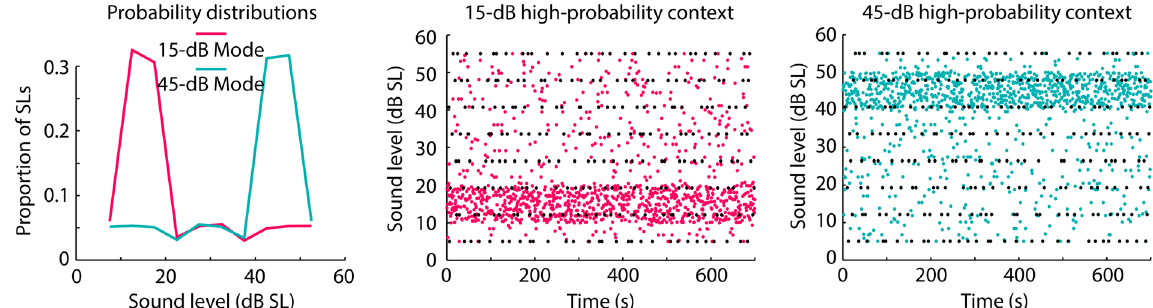
Figure 2. Experimental stimulation used in Experiment I and II. Left: Example probability distributions used for the acoustic stimulation for the two statistical contexts: one had a modal sound level of 15 dB SL, the other one had a modal sound level of 45 dB SL. Middle/right: 1400 white noises with different sound levels (y-axis) were presented at a rate of 0.5 s within a 700-s block (x-axis). Each dot reflects the sound level of one noise stimulus. Black dots indicate the stimuli of interest (targets) for which the effect of sound-level statistics on neural responses (Experiment I) and amplitude-modulation detection performance (Experiment II) was analyzed. For each target burst, its level and the level of the directly preceding noise burst were identical across contexts (15 dB SL and 45 dB SL modal